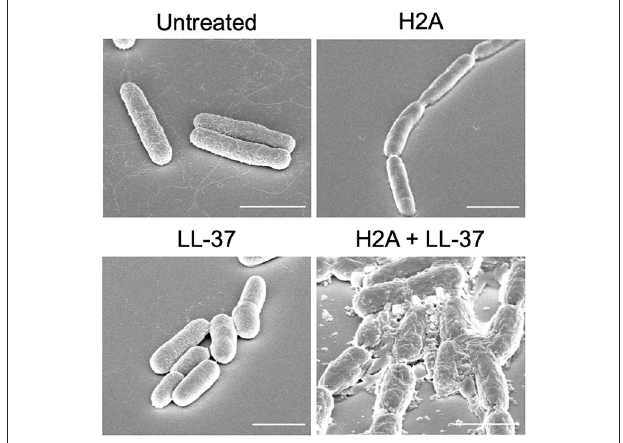
FIGURE 1 | SEM images E. coli that are untreated or treated with H2A, LL-37, or both. E. coli that are treated with both H2A and LL-37 demonstrate extensive cellular damage. Scale bars indicate 2 µ